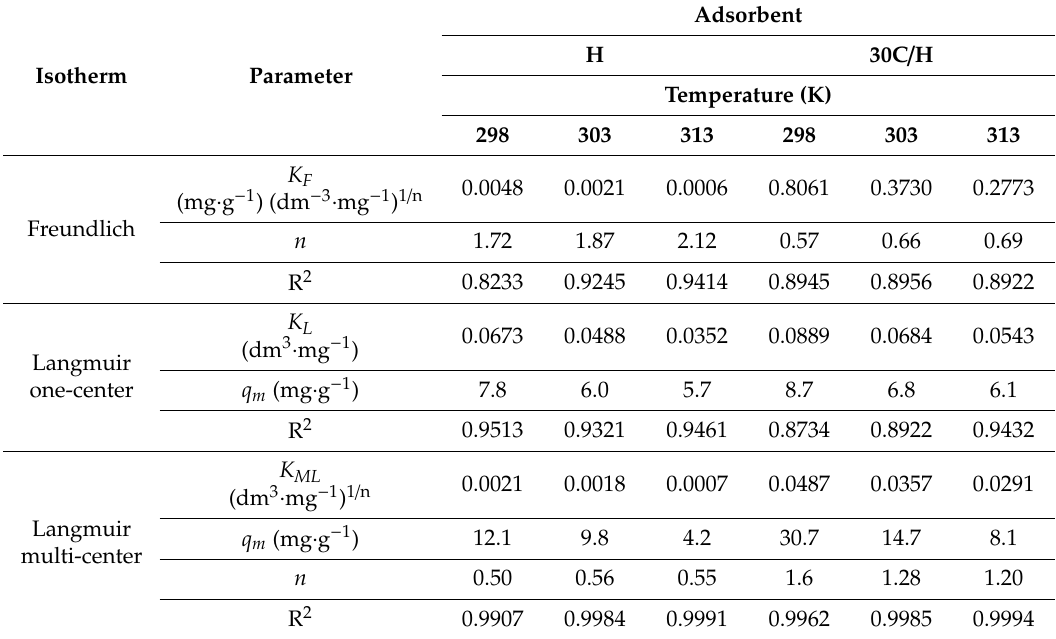
Table 7. Freundlich and Langmuir (one-center and multi-center) equation parameters, and correlation coe ffi cients R 2 for the adsorption of paracetamol on H and 30C / H adsorbents.